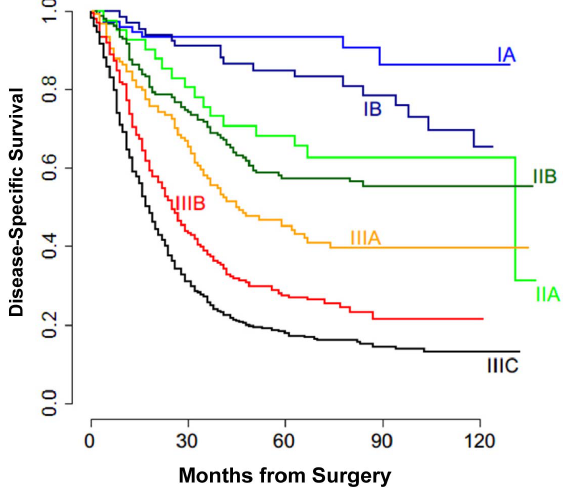
Figure 1. Kaplan-Meier curves of DSS according to the seventh AJCC TNM classification. Kaplan-Meier DSS curves for all patients received R0 gastric cancer resection at Peking University Cancer Hospital & Institute from 1998 to 2007. Each line represents the survival of patients within a single TNM stage.